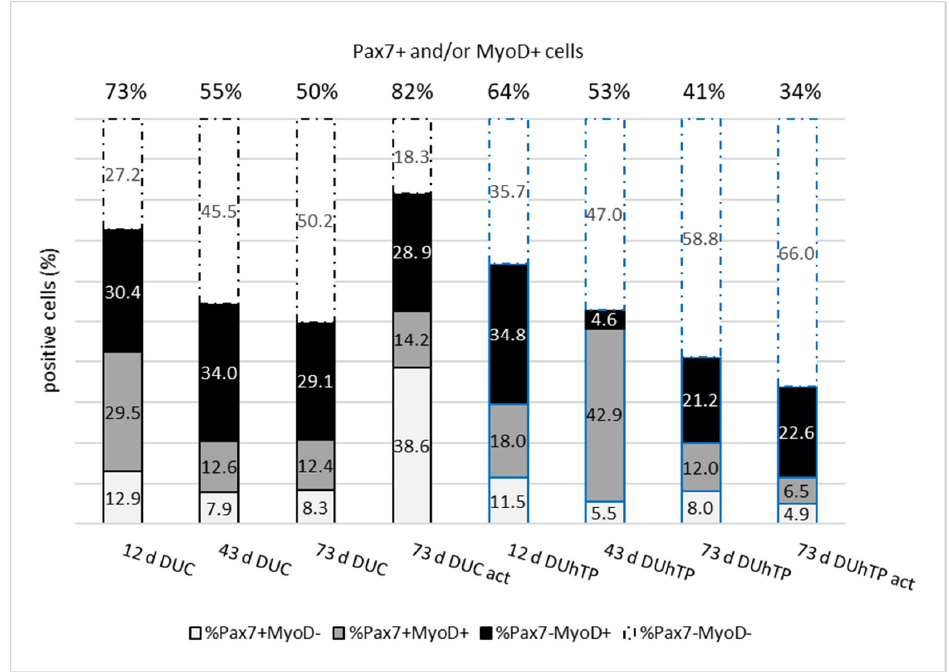
Figure 5. Percentage distribution of Pax7 (white), Pax7 and MyoD (gray), and MyoD (black) positive cells (Pax7+/MyoD−, Pax7+/MyoD+, and Pax7−/MyoD+) derived from sedentary male DUC (left, 12 d: n = 5 mice, 43 d: and 73 d: n = 12 mice, 73 d act: n = 7 mice) and DUhTP mice (right, blue border, 12 d: n = 8 mice, 43 d: n = 4 mice, 73 d: n = 5 mice and 73 d act: n = 3 mice) at the age of 12, 43, and 73 days (d) or from physically active (act) 73-day-old mice. At the top of the columns, the percentage of Pax7 and MyoD negative cells (Pax7−/MyoD−), respectively, of all considered cells, is given. For